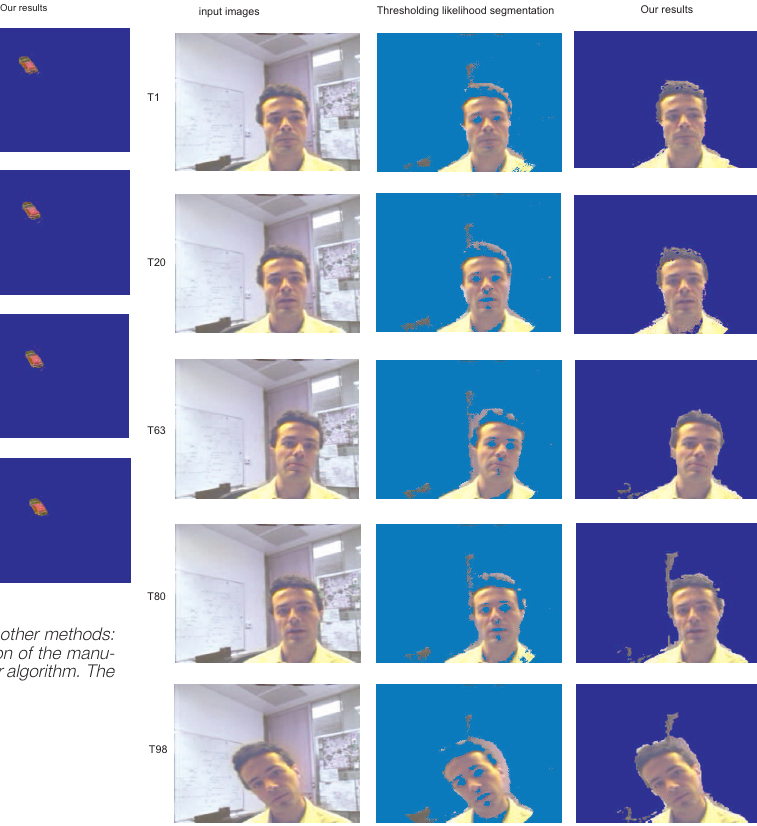
Figure 3. Comparison of our results on the person talking image sequence with other methods: Left: input images; Middle: Results from segmenta- tion of the manually selected difference image. Right: Results from our algorithm.